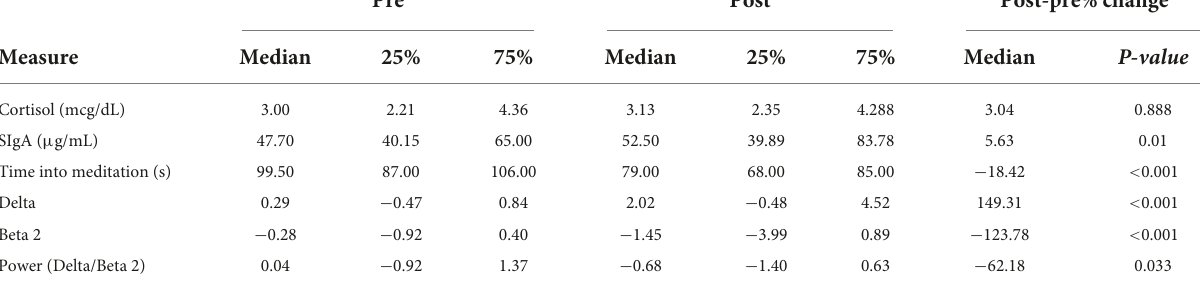
TABLE 2 Experimental group pre- and post-test biological measures ( N = 117). Pre Post Post-pre% change